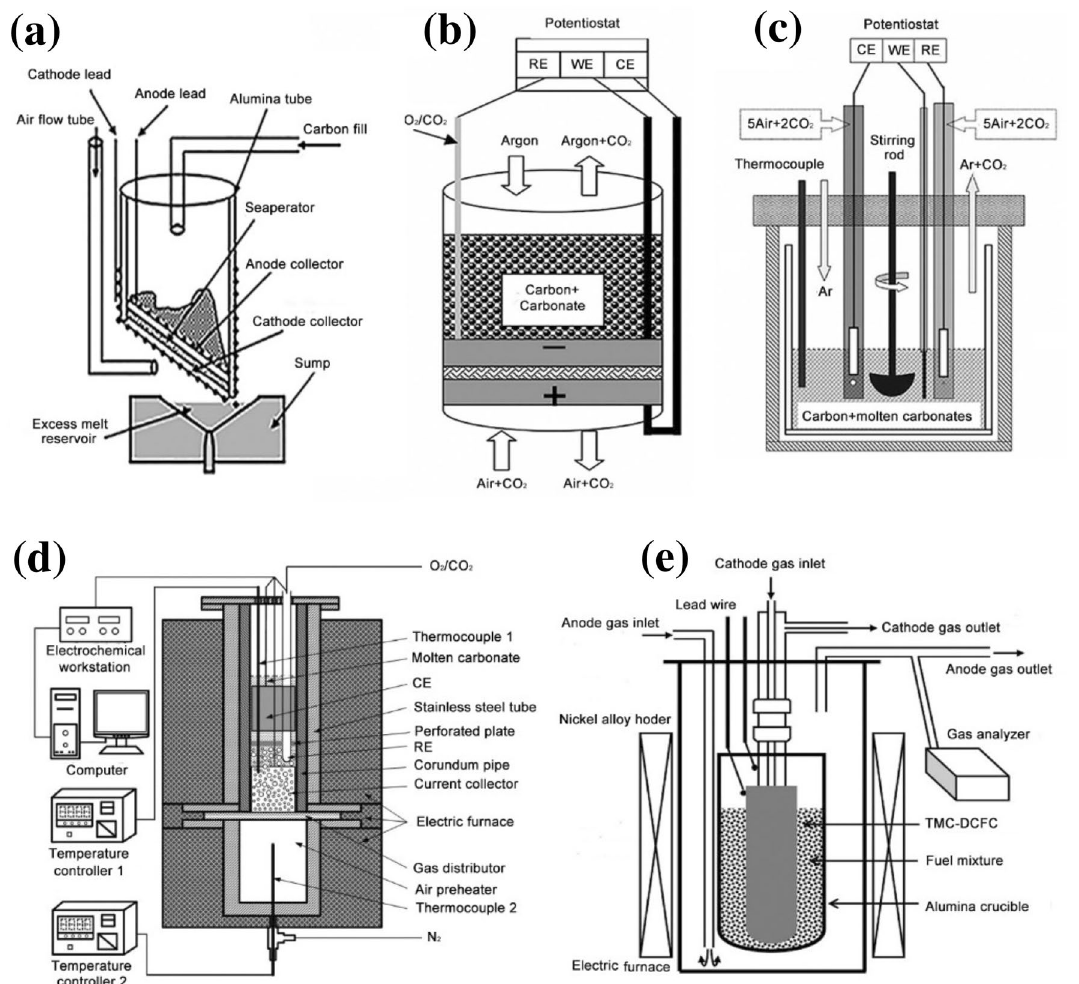
the mass transfer process inside the cell; d FBEDCFC using the bubbling gas to agitate a mixture of carbon and molten carbonate to accelerate mass and heat transfer; e TMC-DCFC with a closed-end structure that ensures there is no short circuit and that there is a con- tinuous solid fuel supply. Reproduced from refs. [41, 95, 96, 98,